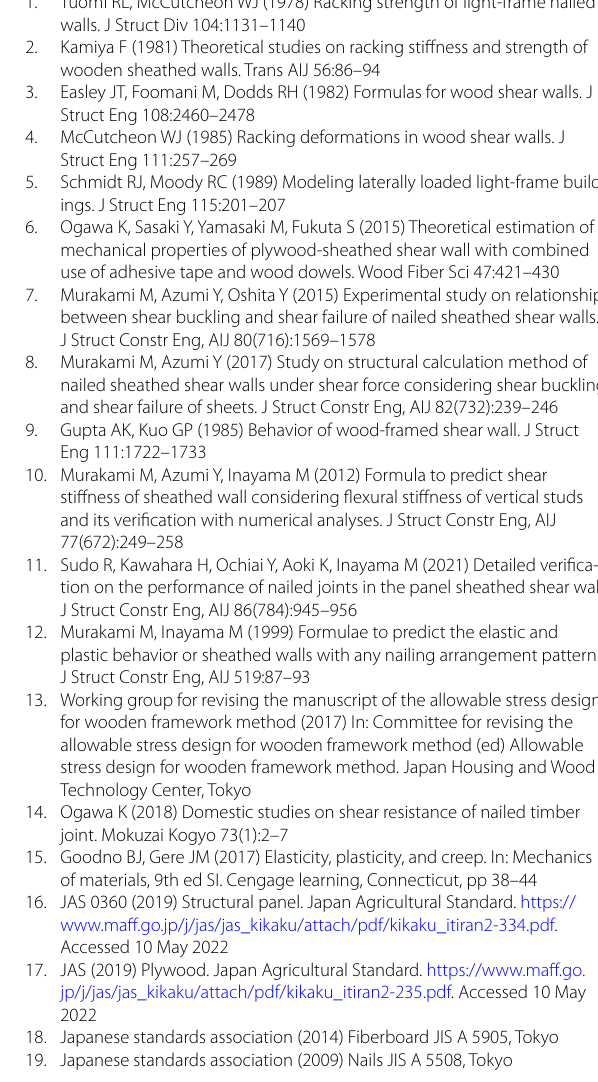
Table 6 Residual displacement at each yield load (unit: mm)